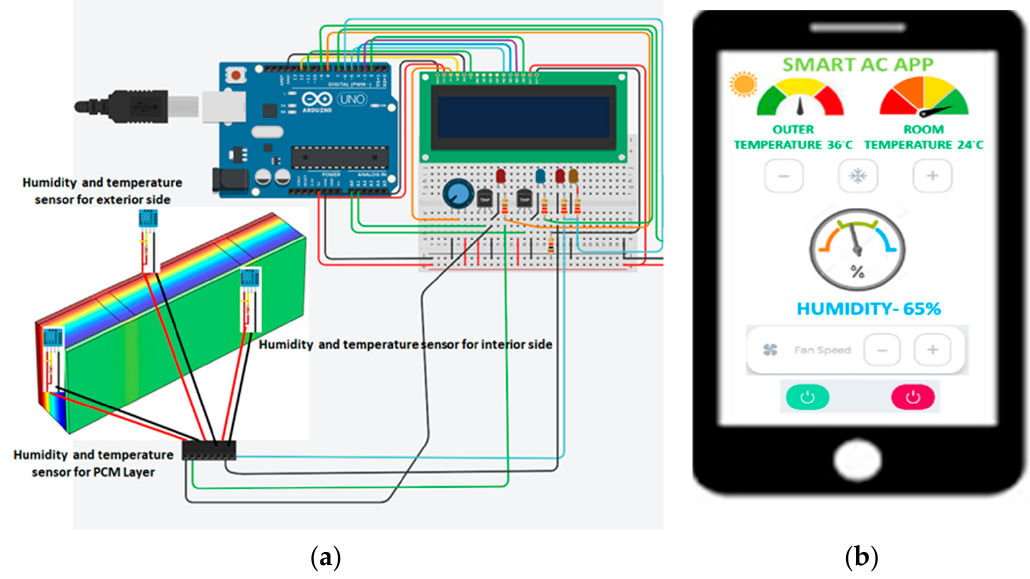
Figure 3. ( a ) Proposed data acquisition with sensor system integration; ( b ) implementable mobile app for smart AC.